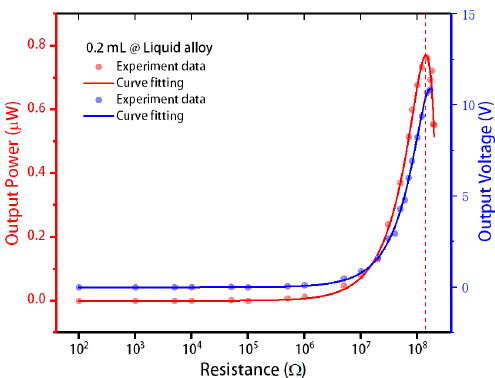
Figure 10. The output performance of stretchable and flexible energy harvesters under di ff erent external loads.